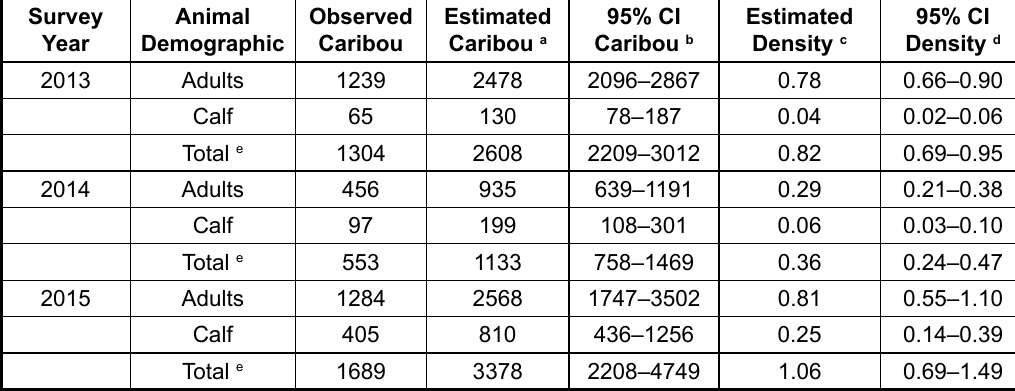
Table 1. Number and density of caribou in the caribou study area in 8-10 June 2013, 13-15 June 2014, and 12-14 June 2015. Survey coverage was 50% of the study